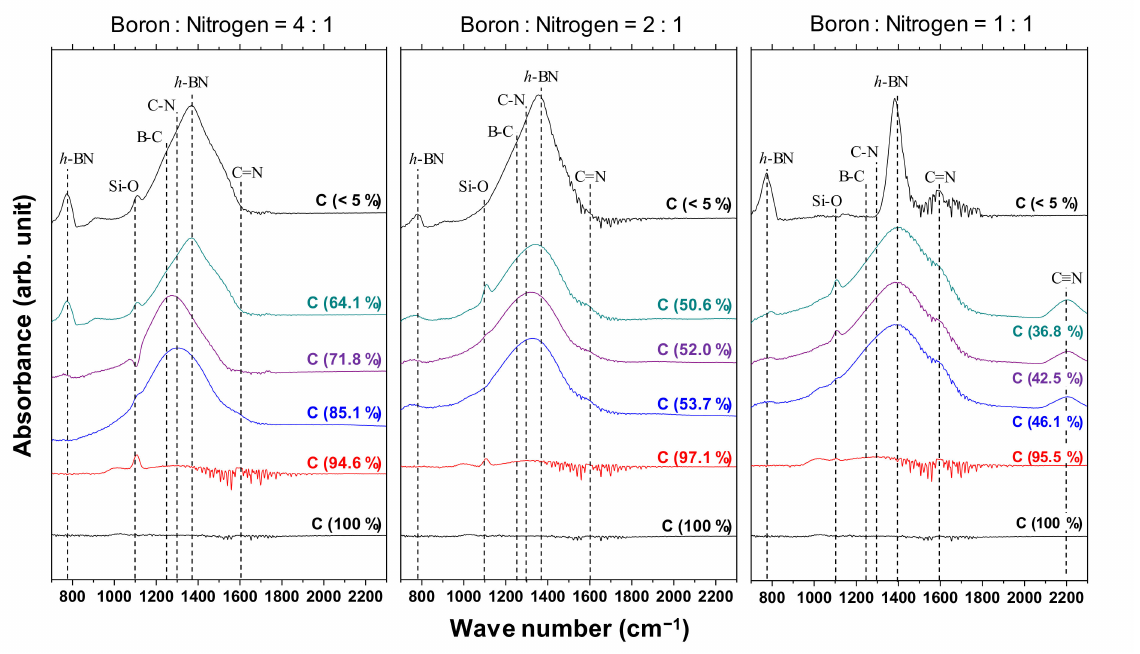
Figure 5. IR spectra of the a-BCN